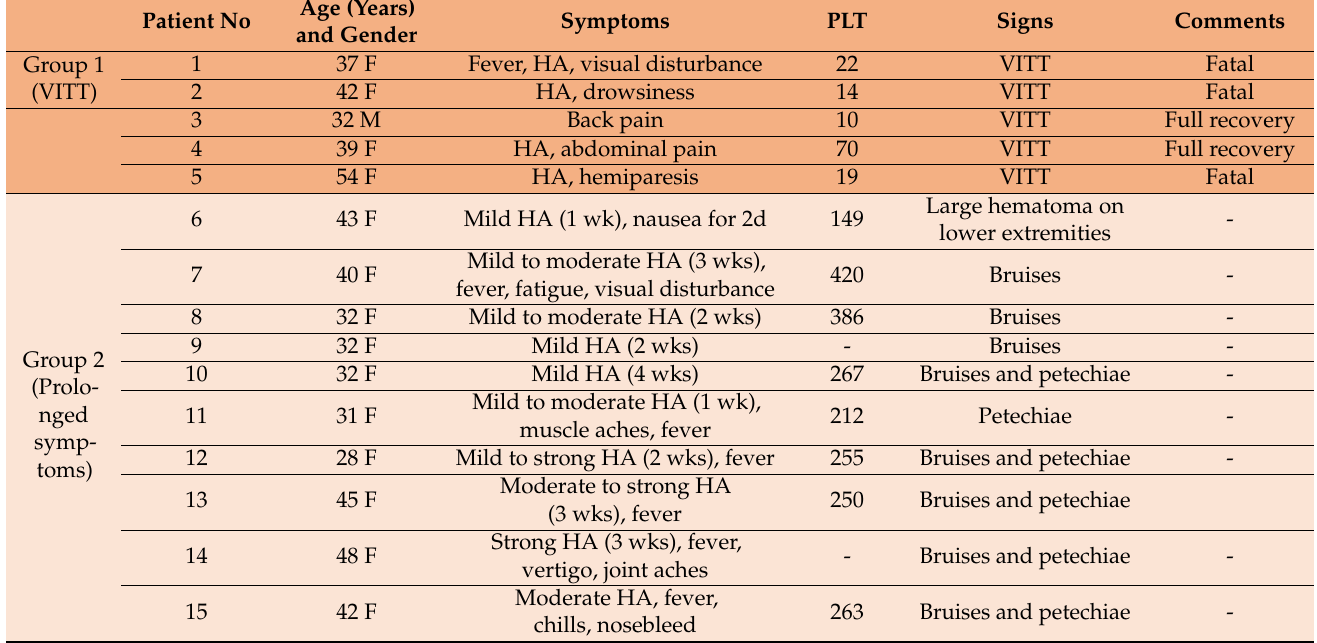
Table 2. ChAdOx1-vaccinated patients with severe symptoms (VITT) (Group 1; no. 1–5),